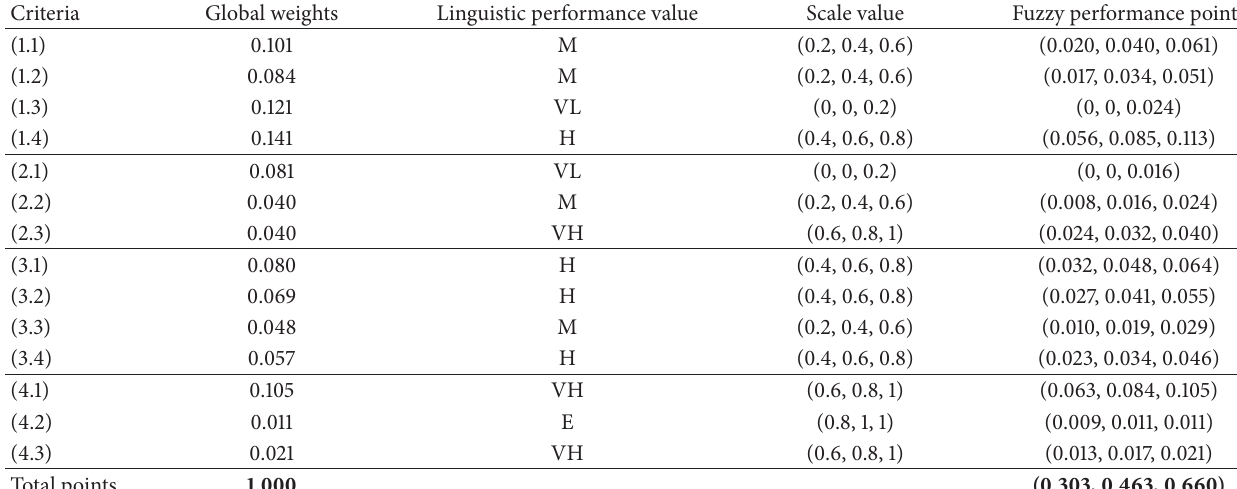
Table 5: Fuzzy performance of Supplier #1 ( 𝐴 1 ).